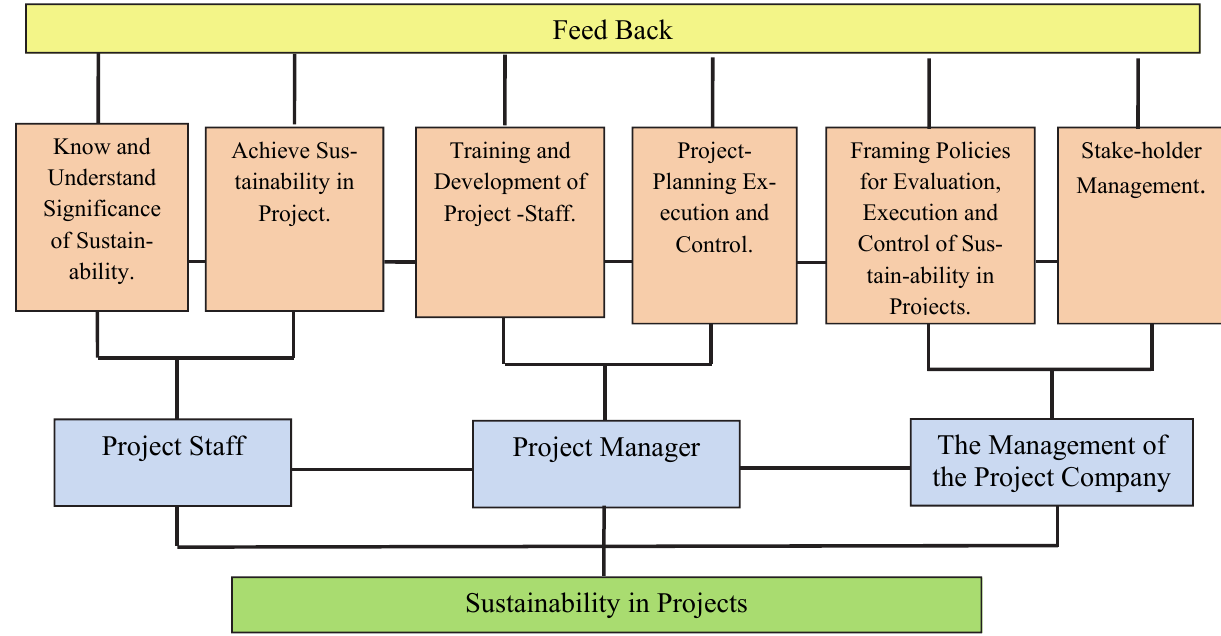
Fig. 2 . Integrated framework for sustainability in